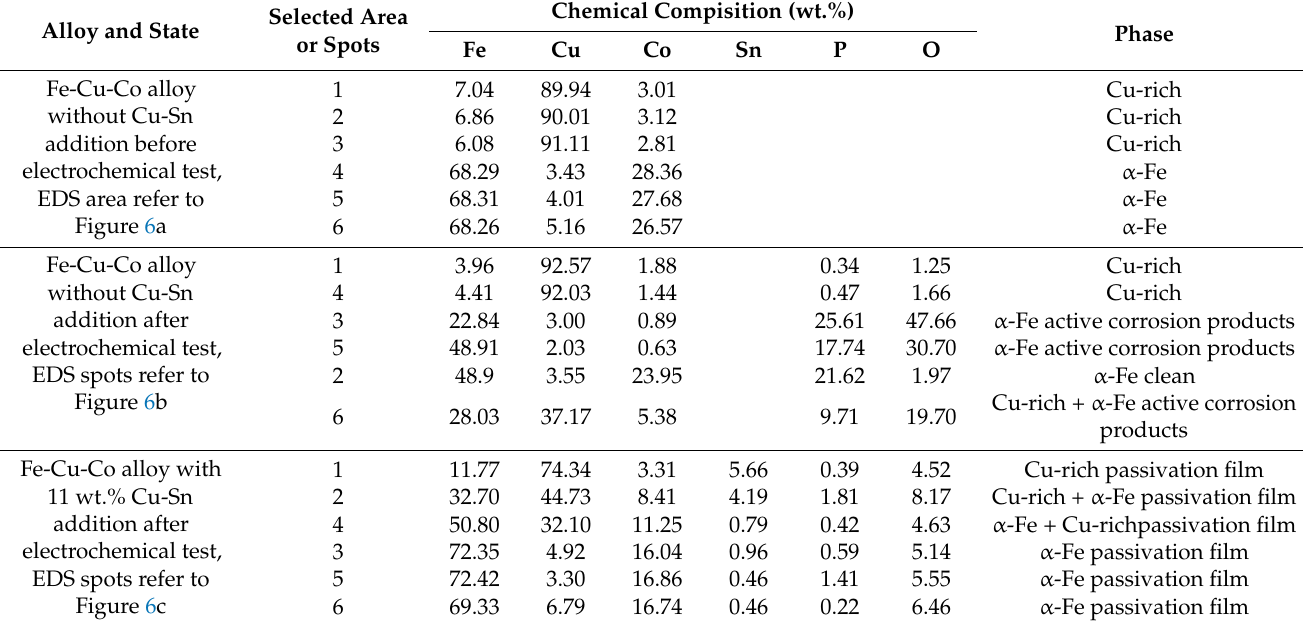
Table 3. EDS selected zone chemical composition analysis results of Figure